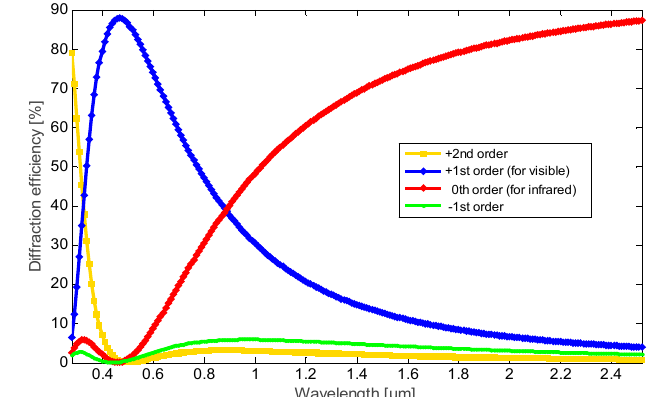
Figure 3. Di ff raction e ffi ciency for di ff erent di ff raction orders in the spectral range from 280 to 2520 Figure 3. Diffraction efficiency for different diffraction orders in the spectral range from 280 to 2520 nm.